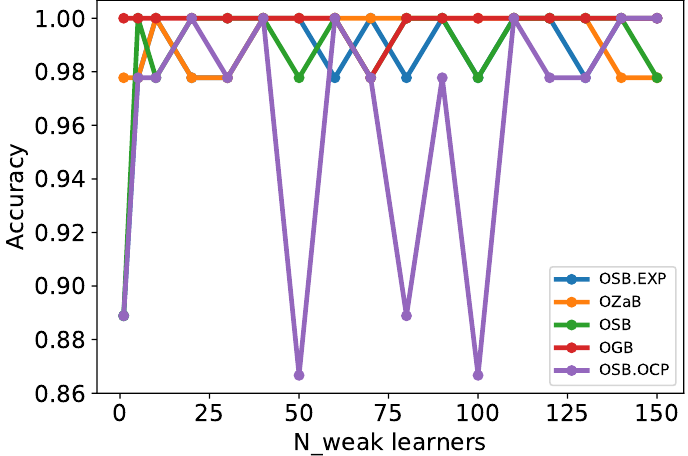
Figure 7. Comparison of online boosting accuracy with the number of weak